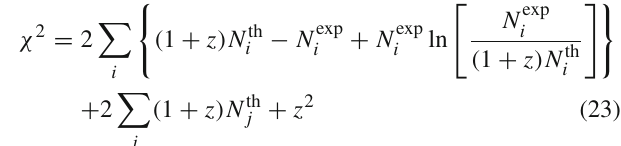
the difference between these two probabilities are